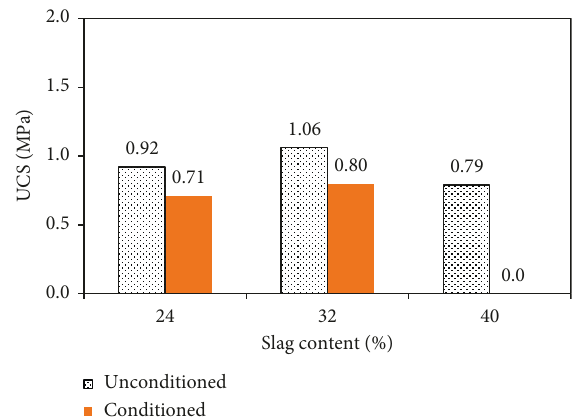
Figure 8: Compression strength results after 7-day curing for LTB.